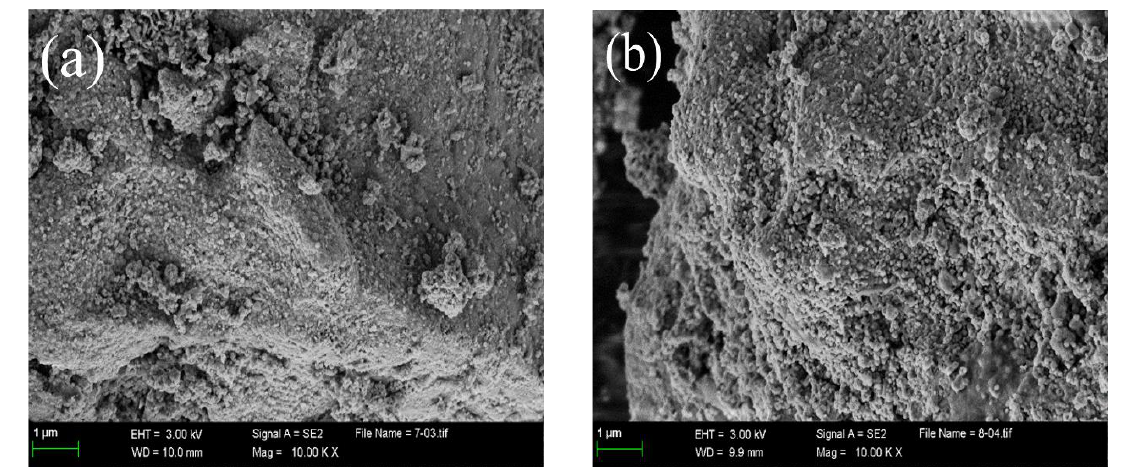
Figure 2. SEM images of ( a ) the fresh La 0 . 6 Sr 0 . 4 CeO 3- δ sample, ( b ) the La 0 . 6 Sr 0 . 4 CeO 3- δ sample after reduction treatment.